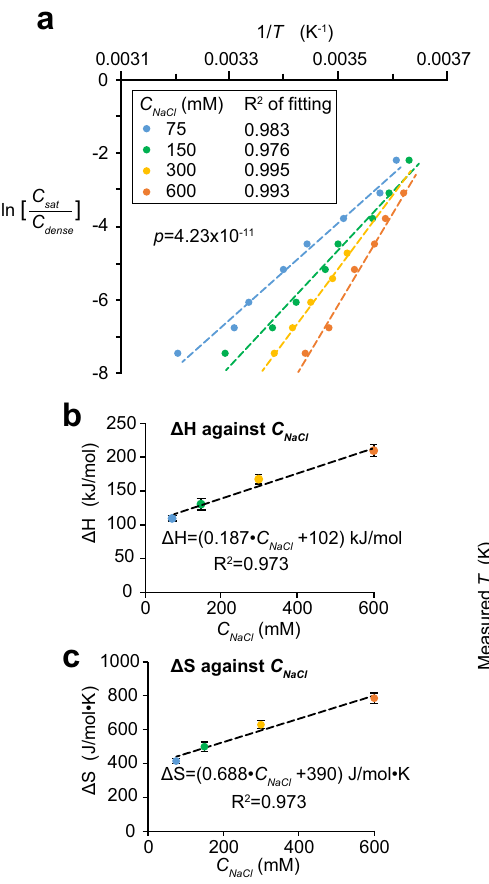
Fig. 4 | Phase separation behaviours of prf.GLFG5 2×12 can be described by thermodynamics. a ln ( C sat / C dense ) is plotted against 1/( transition temperature ) for different C NaCl using dataset from Fig. 3d (each data point is the mean of three replicates), where transition temperature , T is in Kelvin. These plots are known as thevan ’ tHoffplots(Eq.4).Eachplotcanbe fi ttedwithalinearfunctionwithahigh R-squared value. A two-tailed p -value was computed to assess if the differences in slopes of the fi ts are statistically signi fi cant. Δ H and Δ S for phase separation are derivedfromeachlinear fi t(seeSupp.Table2,Risthegasconstant). b , c Δ H and Δ S derived from best- fi ts in a were plotted against C NaCl , respectively. Data are pre- sented as mean values with S.E. of fi tting as error bars (see also Supp. Table 2).